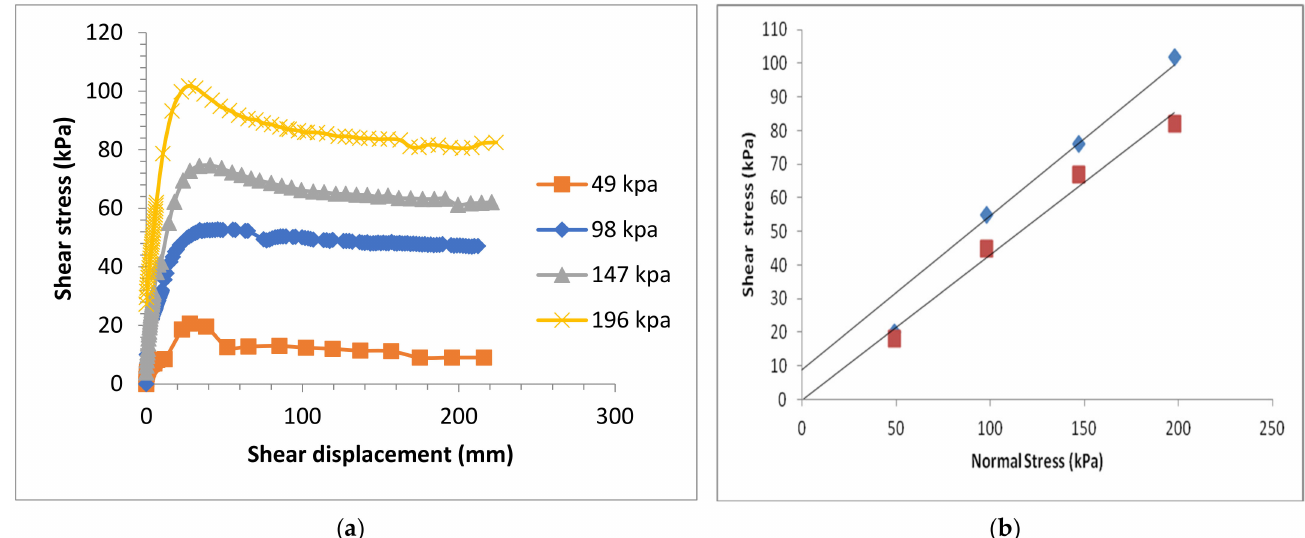
Figure 12. Estimation of shear strength parameters from drained ring shear test for Upputhode topsoil samples. ( a ) Shear stress (vs.) shear displacement plot. ( b ) Peak and residual failure